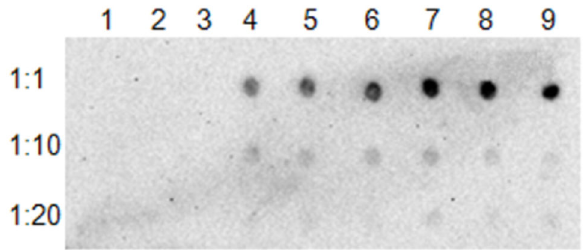
Figure 3. Surface location in E. coli of the autotransporter Figure 4. Surface localization in E. coli of GFP fusion LasA as determined by immuno-dot blot analysis. Serial I proteins of LasA and LasA by immuno-dot blot. Serial dilutions of E. coli cells were deposited onto a nitrocellulose I II dilutions of bacterial cells were deposited onto a nitrocellulose membrane. The presence of LasA was detected with anti- I membrane; GFP was detected with anti-GFP antibody. Lane 1, LasA antibody. A : E. coli containing control plasmid pET102; I 2, 3 : IPTG induced E. coli containing plasmid pET102- gfp ; B : IPTG-induced E. coli containing recombinant plasmid Lane 4, 5, 6 : IPTG-induced E. coli containing plasmid pET102- lasA ; C : IPTG induced E. coli containing recombinant I plasmid pET102- lasA treated with Proteinase K. I